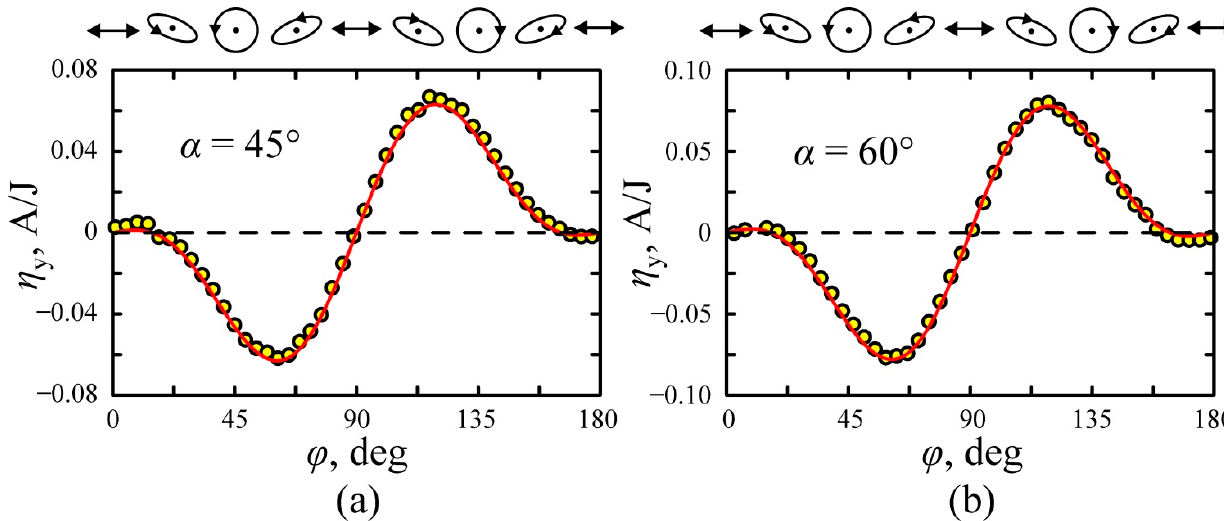
Figure 9. Dependences of the transversal conversion efficiency on quarter-wave plate orientation φ at ( a ) α = 45° and ( b ) α = 60°. The solid lines show fitting by Equation (28) at parameters in Table 1. Polarization ellipses as seen by the observer looking at the excitation beam source are shown at the top.